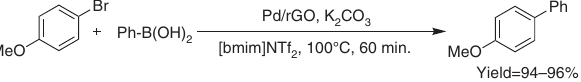
Scheme 2: Catalyst recycling protocol.